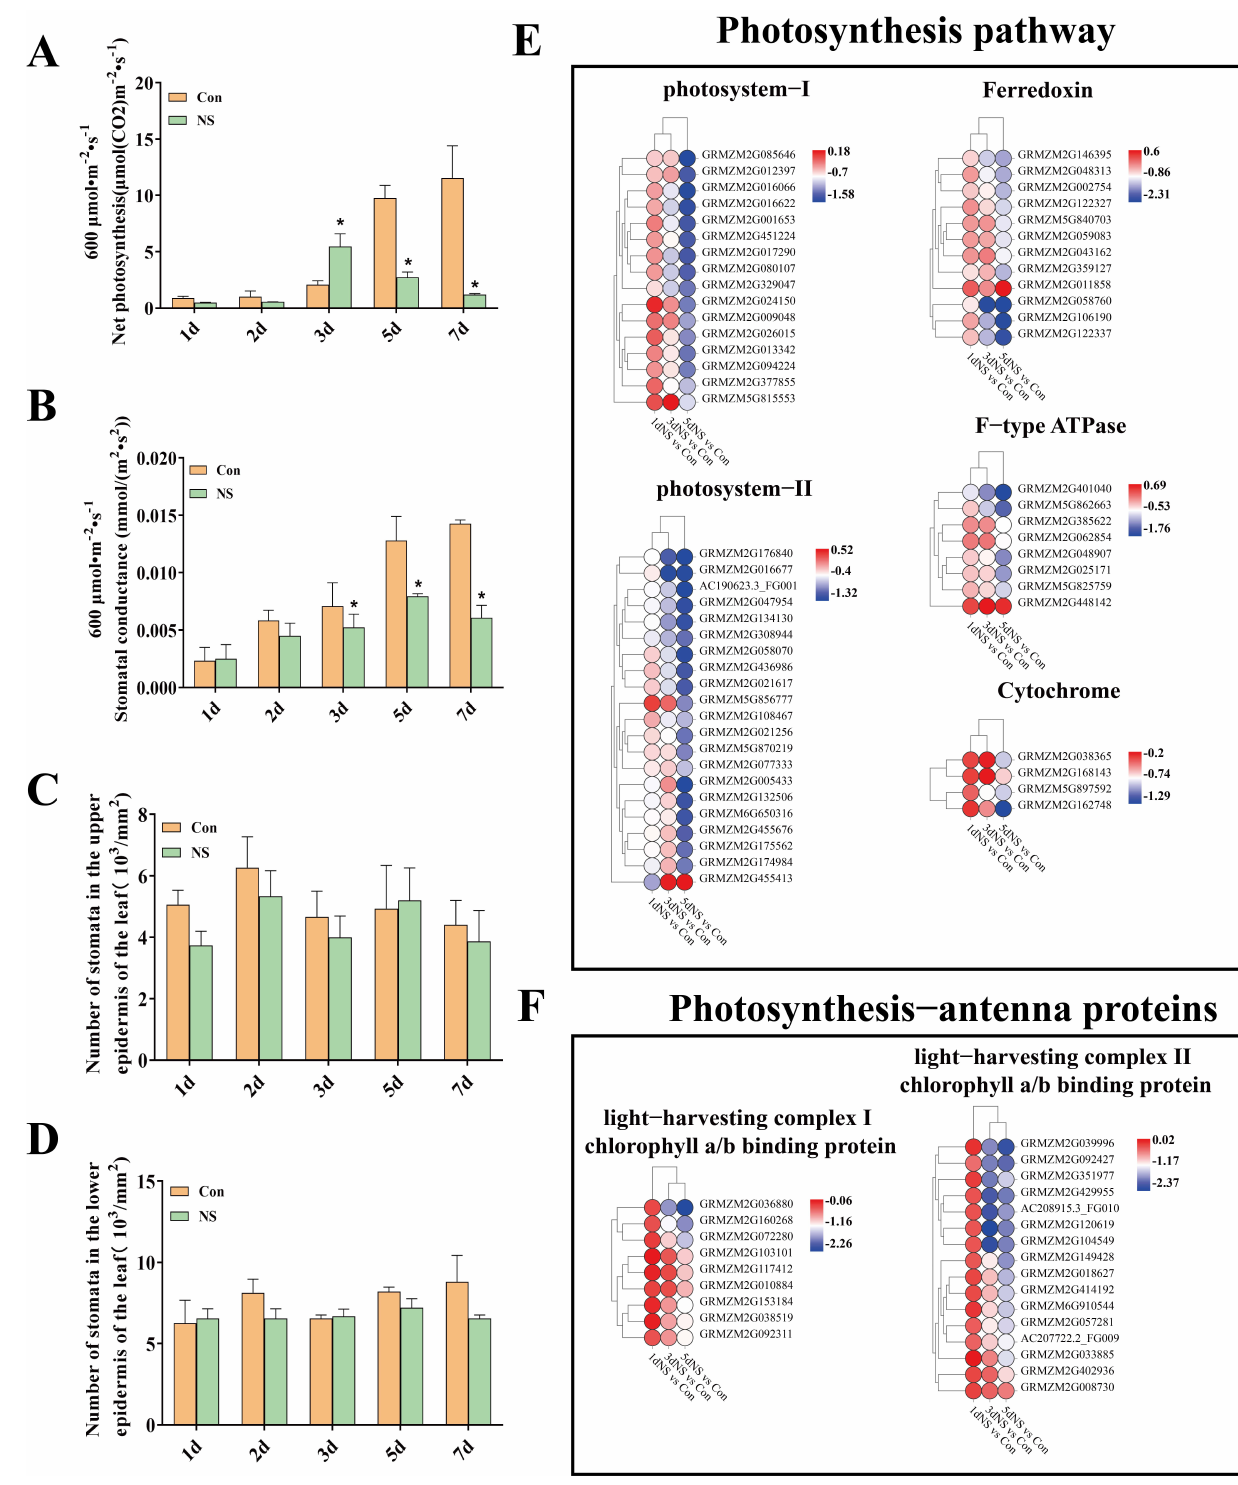
Figure 3. Changes in photosynthesis in maize seedling leaves under phospholipase C inhibition. ( A ), net photosynthesis; ( B ), stomatal conductance; ( C ), number of stomata in the upper epidermis of the leaf blade; ( D ), number of stomata in the lower epidermis of the leaf blade; ( E ), photosynthetic pathway (ko00195); ( F ), photosynthetic antenna proteins (ko00196). Values are shown as mean ± SD ( n = 3 individuals per group). * means that the difference from the control reaches a significant level, p <